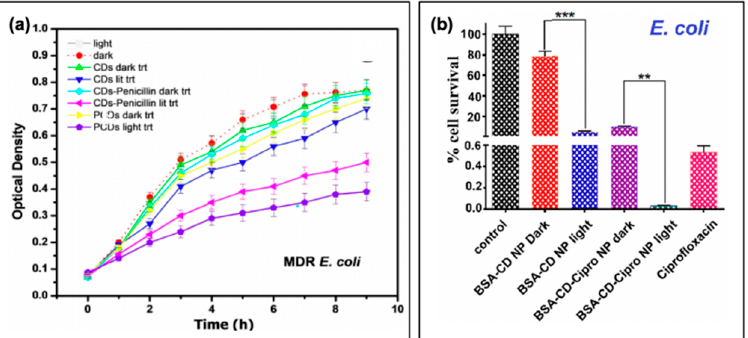
Figure 10. Carbon nanodots in hybrid systems with antibiotics. ( a ) Bacterial growth curves for multi-drug resistant (MDR) E. coli with treatment using either penicillin conjugated (CDs-Penicillin) or penicillin precursor (PCDs) carbon dots (CDs). ( b ) Cell viability of Esherichia coli after treatment with the carbon nanodot structure (BSA-CD NP) alone or loaded with ciprofloxacin (BSA-CD-Cipro NP) both under light and dark conditions. For additional details regarding the reported studies, the reader is referred to Table 2 of the main text. Abbreviations: BSA (bovine serum albumin), NP (nanoparticle), CD (carbon nanodot). Permissions : ( a ) Adapted with permission from Reference [19]. Copyright © 2017, John Wiley and Sons. ( b ) Adapted with permission from Reference [3]. Copyright © 2019, American Chemical Society.